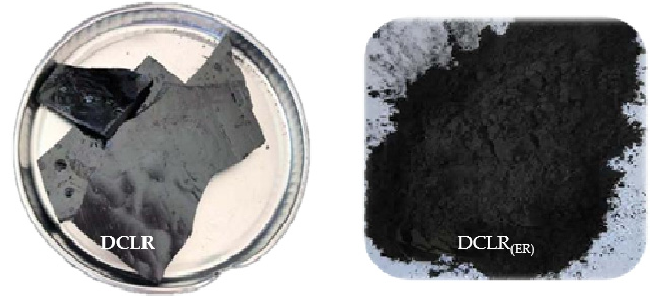
Figure 11. The images of DCLR and DCLR (ER).